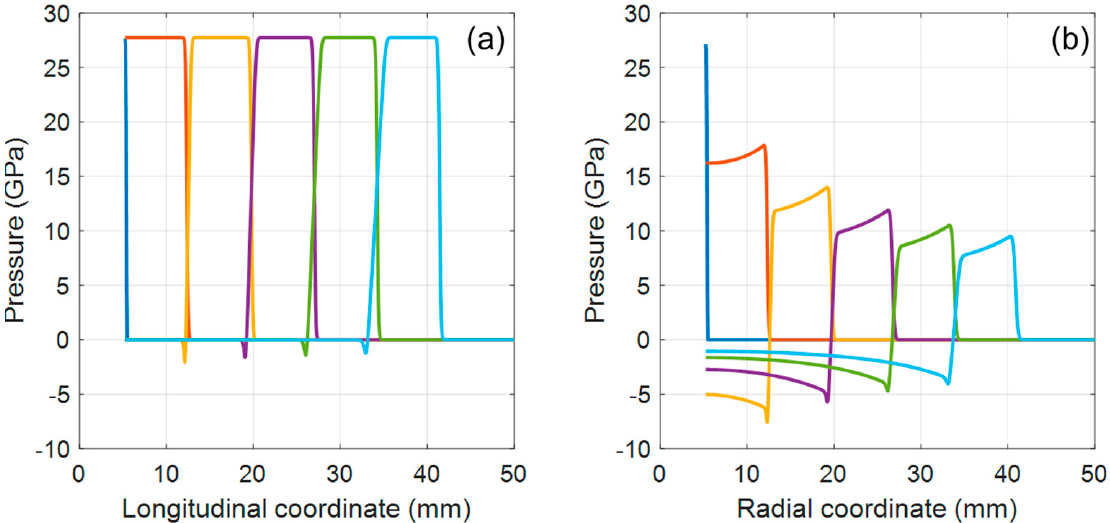
Figure 6. Pressure as a function of longitudinal coordinate for plane strain case ( a ) and pressure as a function of radial coordinate for the axisymmetric case ( b ) at different times.